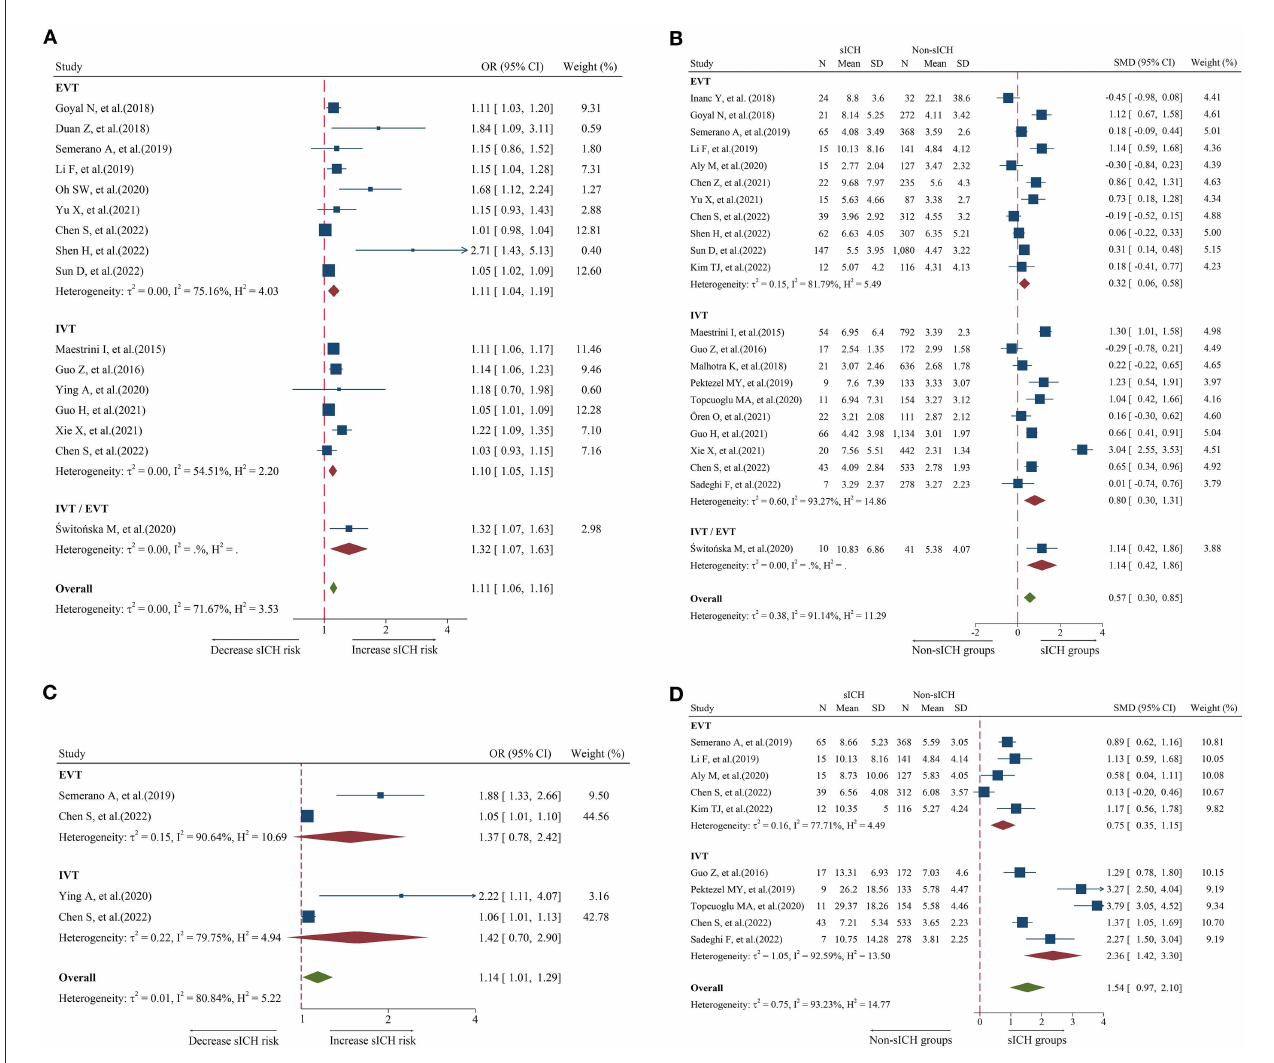
FIGURE3 Forest plot showing the association of NLR and sICH; (A) forest plot of admission NLR based on OR; (B) Forest plot of admission NLR based on SMD; (C) Forest plot of post-treatment NLR based on OR; and (D) forest plot of post-treatment NLR based on SMD.